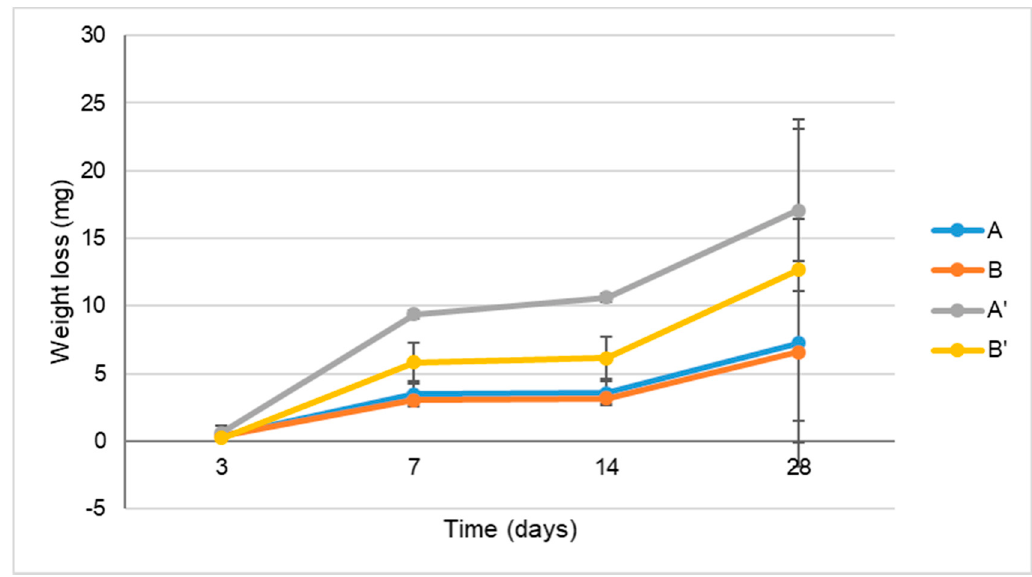
Figure 4. Mass loss after degradation in SBF of the collagen/nanoHA samples before and after sterilization, for different periods.